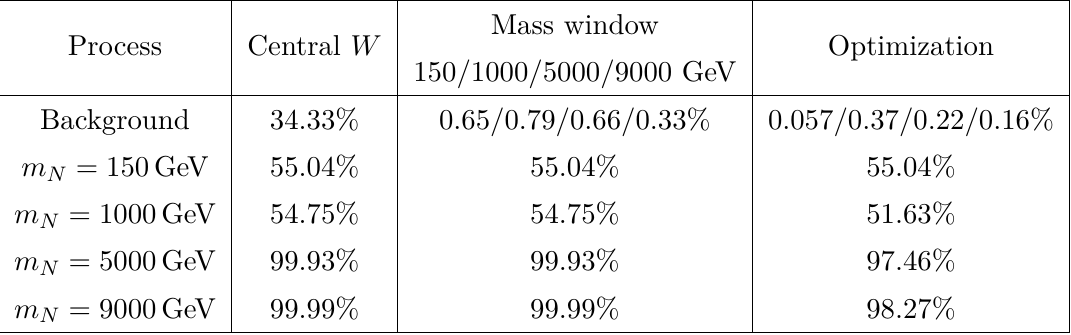
Table 10 . Cutflow table for N µ at 10 TeV. All processes after pre-selection are set to